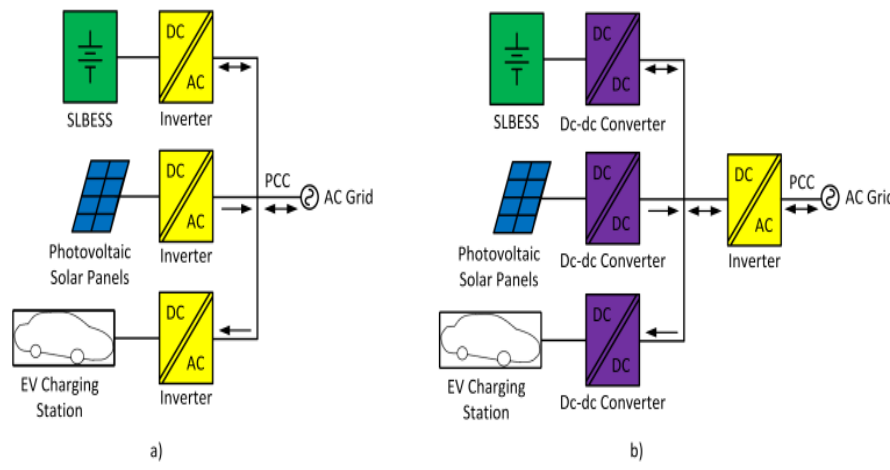
Figure 3. Block diagrams of microgrids with an SLBESS: ( a ) the AC microgrid and ( b ) the DC mi- crogrid.